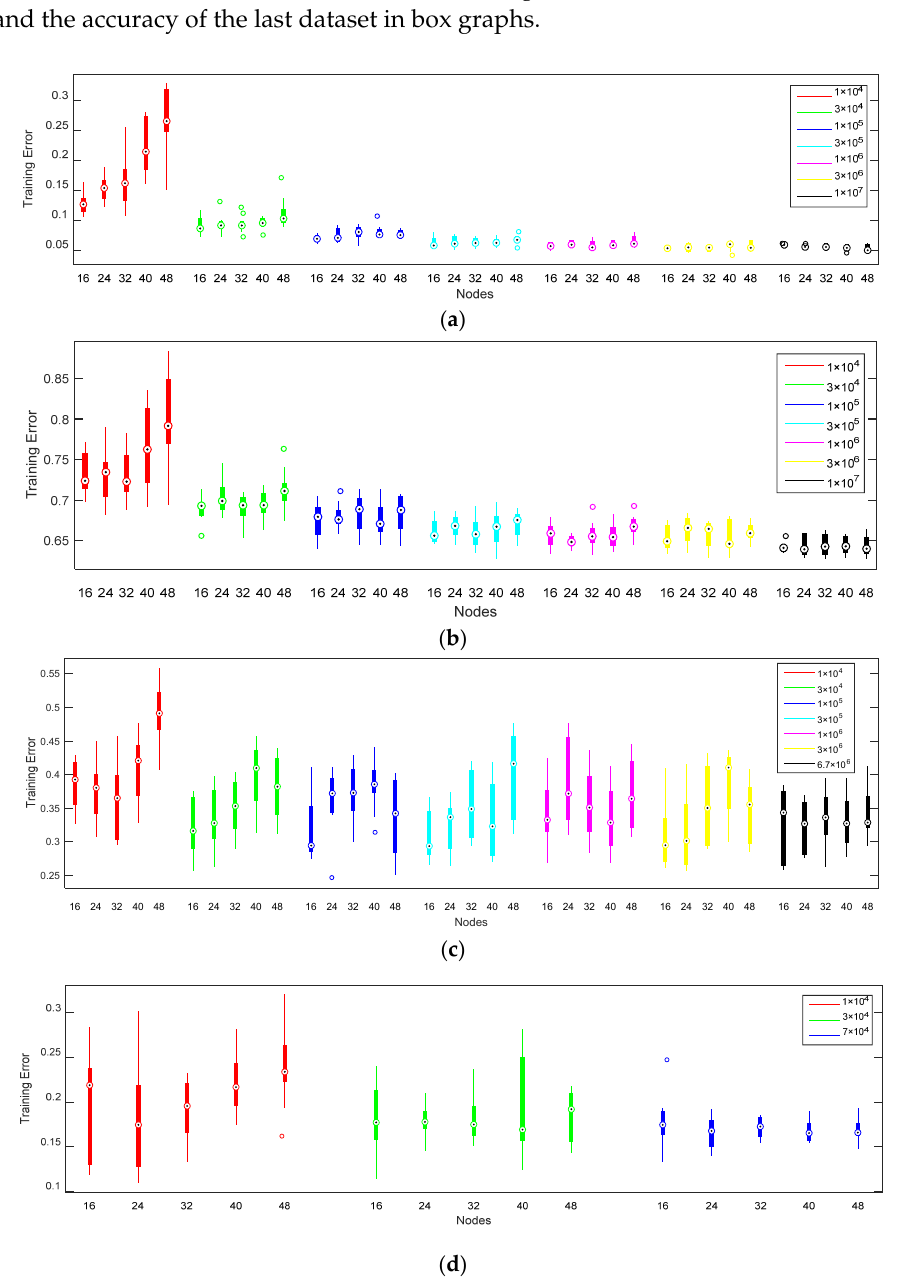
Figure 8. NRMSE of each dataset in different lengths and nodes. ( a ) NRMSE of dataset 1; ( b ) NRMSE of dataset 2; ( c ) NRMSE of dataset 3; ( d ) Accuracy of dataset 4.